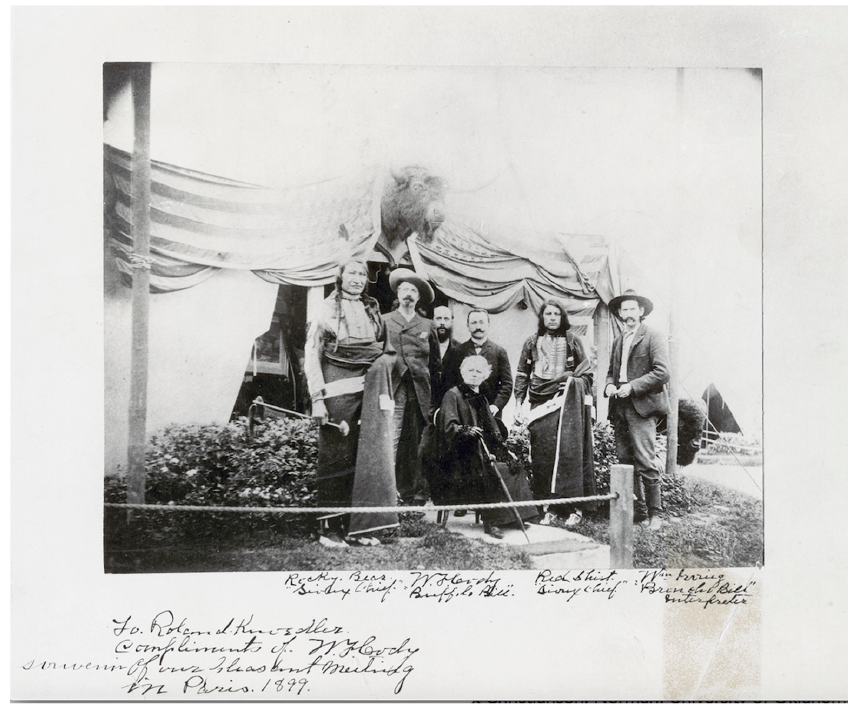
Figure 17. William F. Cody and group at Buffalo Bill’s Wild West show, Paris, 1889.